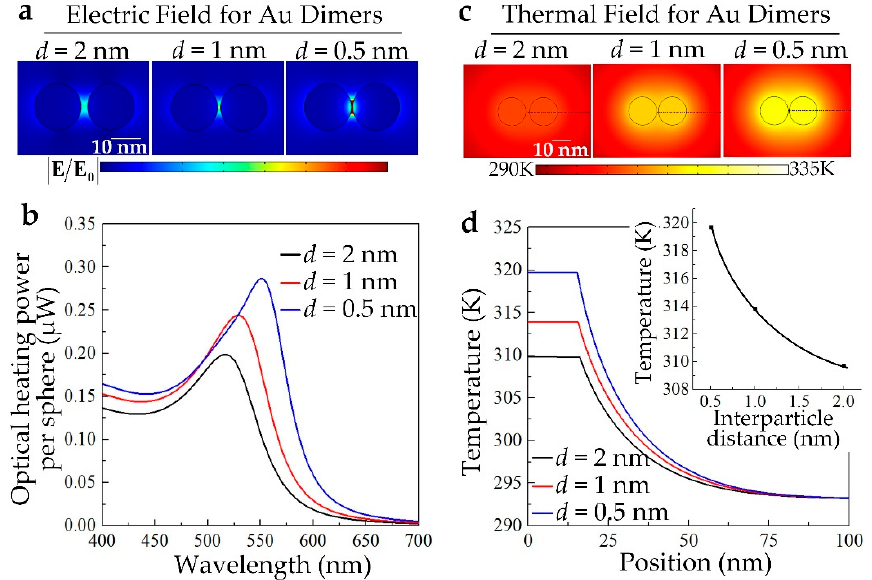
Figure 4. ( a ) LSPR-induced electric field enhancement for gold nanodimer with different gap distance; d is the gap distance between the plasmonic individuals; ( b ) The per-sphere-weighted optical heating power for gold nanodimer with different gap distance; ( c ) Corresponding quantitative temperature fields for gold nanodimer with different gap distance at t = 5 ns; the laser irradiance is 0.15 mW/ μ m 2 ; ( d ) Temperature distribution along the dotted lines in ( c ). The inset indicates the nonlinear temperature dependence on the interparticle distance.